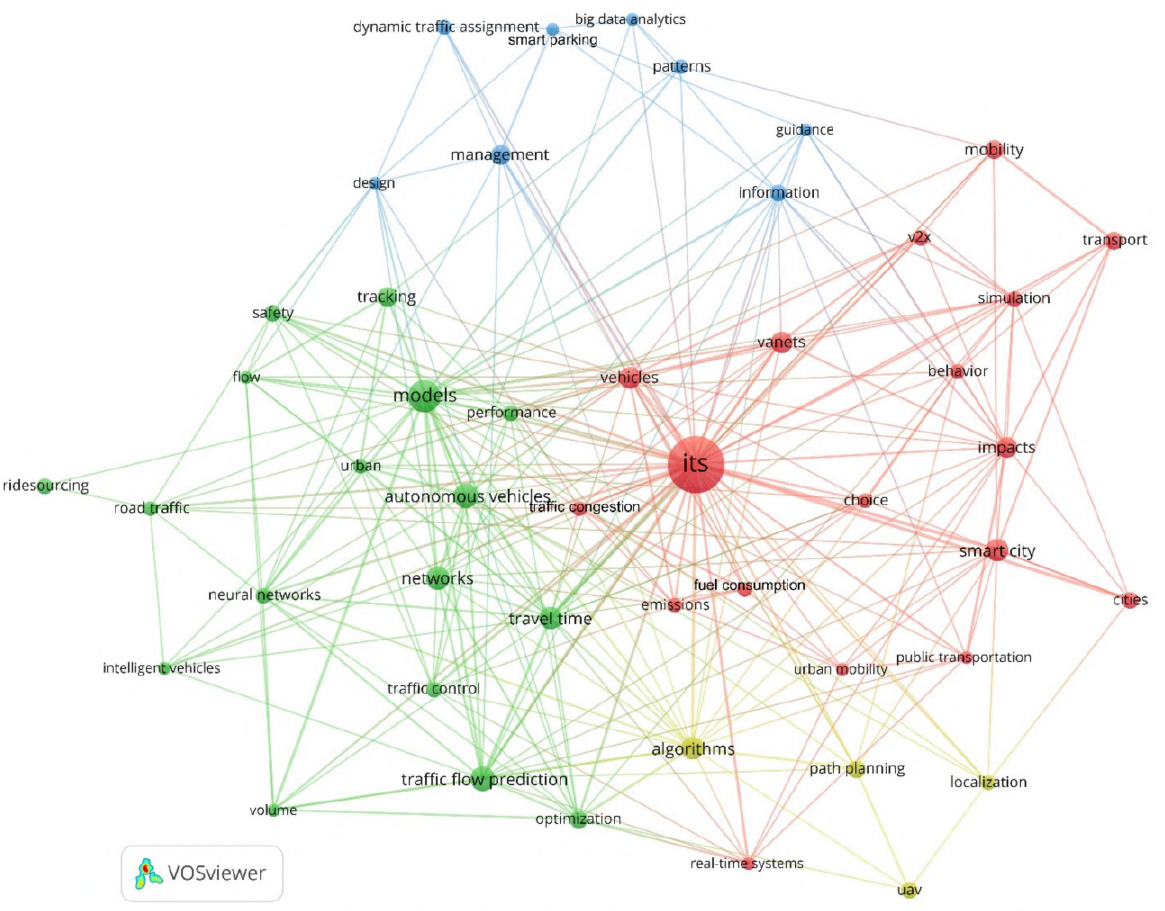
Figure 9. Mapping Keywords Output from 2011 to 2015. Illustration by